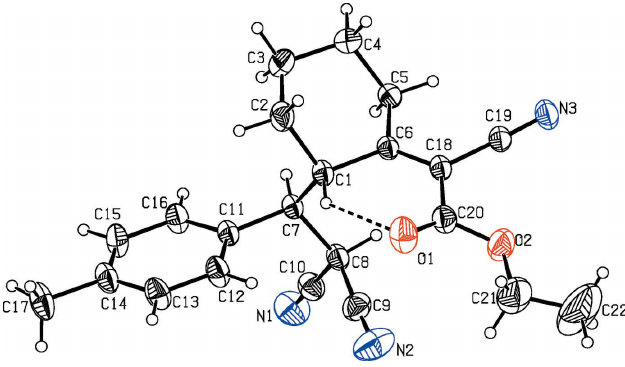
Figure 1 The molecular structure of the title compound, with atom labelling. Displacement ellipsoids are drawn at the 30% probability level. The intramolecular C—H (cid:3)(cid:3)(cid:3) O hydrogen bond is shown as a dashed line.